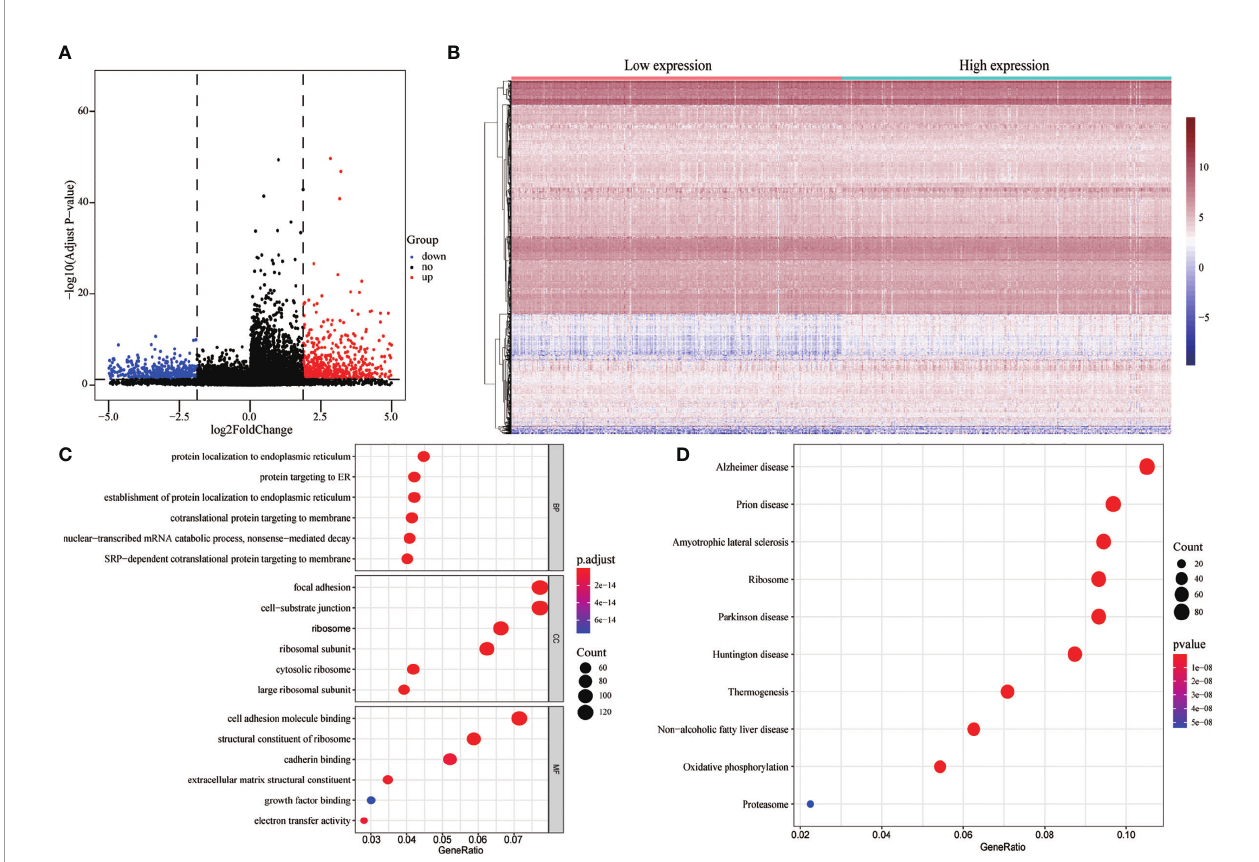
FIGURE 7 | Analysis of differentially expressed genes (DEGs) between high and low fetal-lethal non-coding developmental regulatory RNA (FENDRR) expression groups. (A, B) Volcano plot and heat map of DEGs. (C, D) DEGs enriched for biological signaling